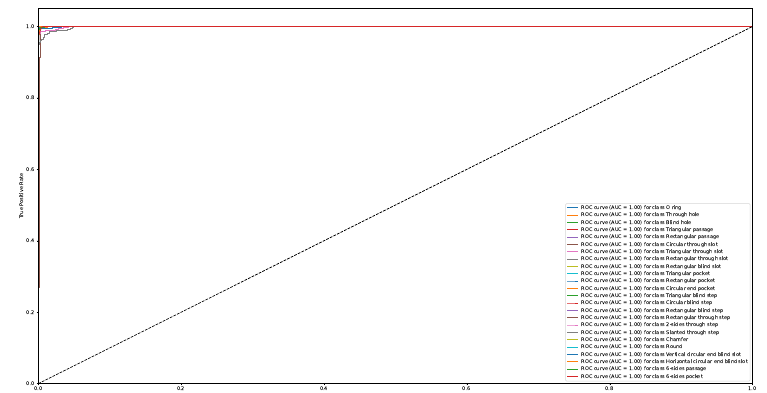
Figure A10. ROC curve for MsvNet